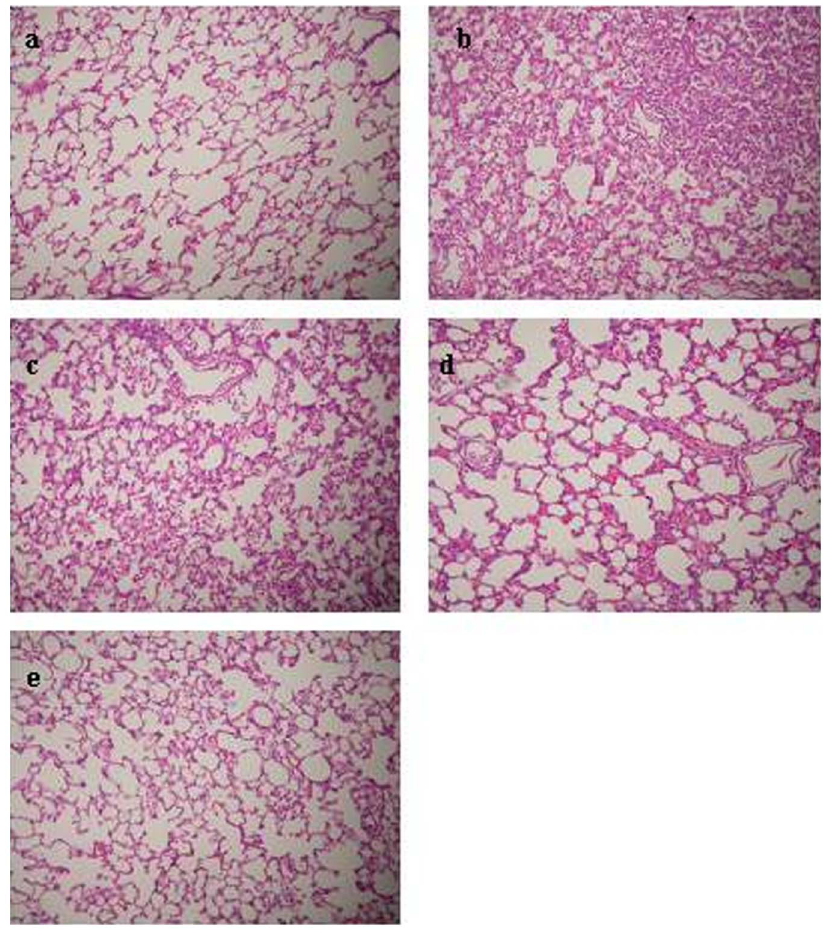
Figure 3. Histology of representative lung sections of rats. Significant numbers of inflammatory cells migrated into the alveolar spaces, the alveolar walls showed destructive changes and alveolar congestion in the NF and LR group (panel b, panel c). The attenuation of lung injury with HTS and HES treatment group was noted (panel d, panel e). Five rats were examined in each group. Sections were stained with hematoxylin and eosin stain. Original magnification: 6